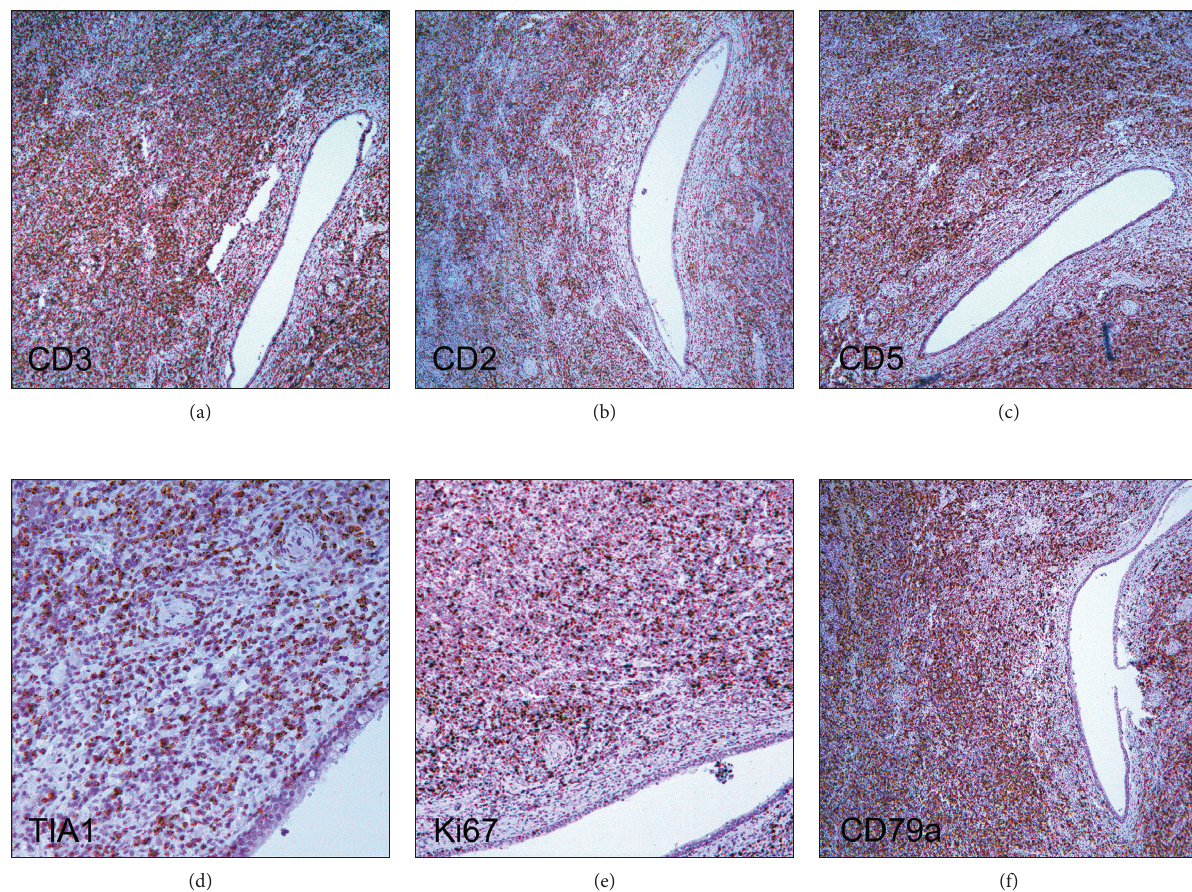
Figure 3: Submandibular salivary gland. (a) Immunohistochemistry for CD3 shows diffuse infiltration by CD3+ T cells, × 50. (b) T cells express CD2, × 50. (c) T cells express CD5, × 50. (d) T cells express TIA1, × 200. (e) Proliferative activity marker Ki-67 in the T-cell area is expressed by up to 70% of the cells, × 100. (f) The neoplastic T cells coexpress CD79a, ×